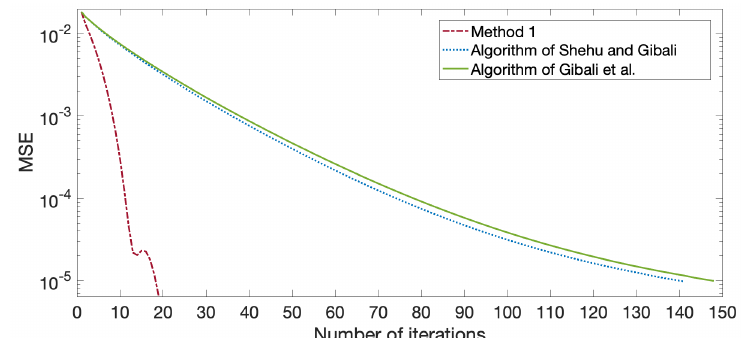
Figure 1. Graph of MSE and number of iterations for P = 2048, K = 1024, m = 30 when MSE < 10 − 5 .